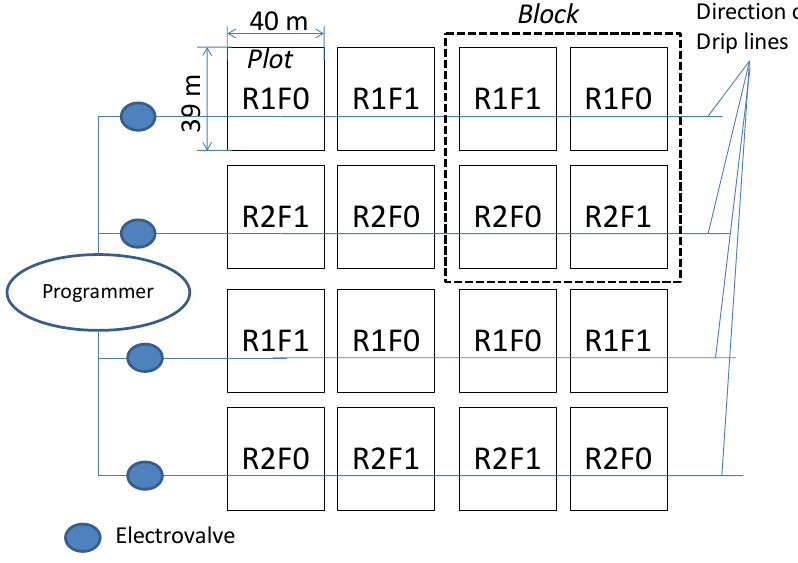
Figure 3. Experimental design to analyze the treatments effects on stem biomass of Paulownia trees. Each block represents a replication; R1F0: irrigation with 1000 liters/tree without fertilization; R1F1: irrigation with 1000 liters/tree and fertilization; R2F0: irrigation with 2000 liters/tree without fertilization; R2F1: irrigation with 2000 liters/tree and